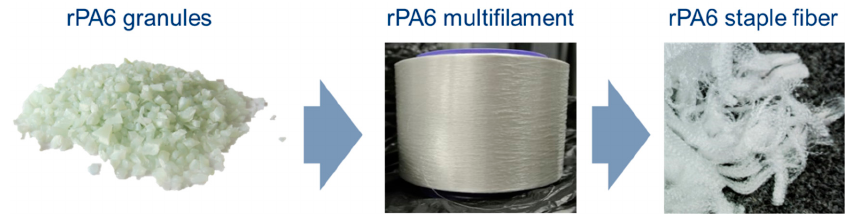
Figure 2. Manufacturing steps of rPA6 staple fibers from rPA6 granules.